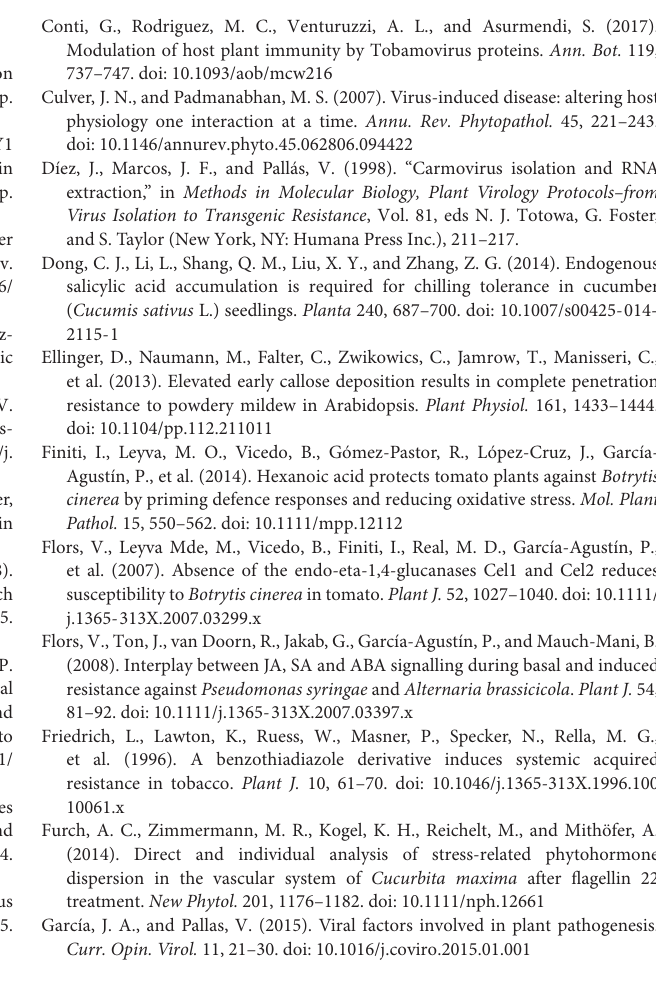
FIGURE S1 | Effect of Hx treatment on MNSV disease severity. The 1-week-old melon plants were treated with 16 mM of Hx by foliar spray and by soil drench, and with 4 mM of Hx at 3 days and 1 day before, and at 1 day, after virus inoculation. (A) The number of spots per cotyledon at 5 dpi. (B) The number of plants with systemic symptoms at 18